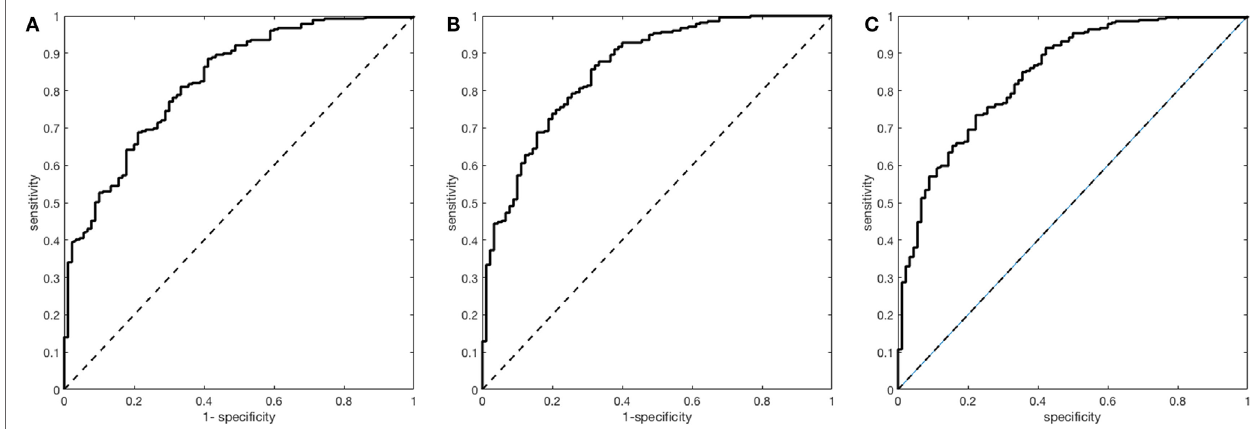
FigUre 1 | Receiver operating characteristics analyses for the prediction of good functional outcome in the overall stroke cohort. (a) Multivariate model with baseline National Institutes of Health Stroke Scale (B-NIHSS) and age [area under the curve (AUC) = 0.82; 95% CI 0.78–0.87]. (B) Multivariate model with B-NIHSS, age, and Delta National Institutes of Health Stroke Scale (AUC = 0.86; 0.82–0.90). (c) Multivariate model with B-NIHSS, age, and major neurological improvement (AUC = 0.84;